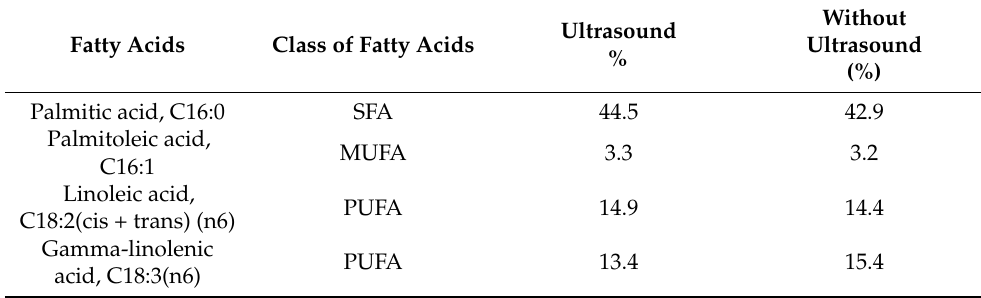
Table 4. Fatty acid composition of lipid extract from Spirulina spp. with and without ultrasound